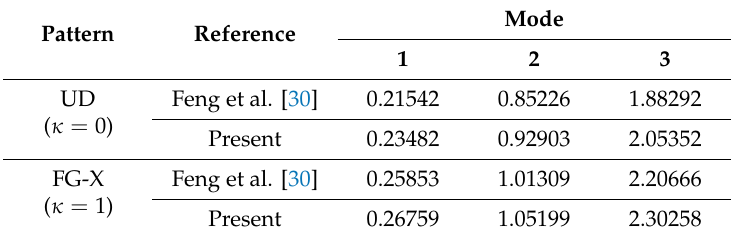
(cid:112) m 10 / A 10 ) of simply